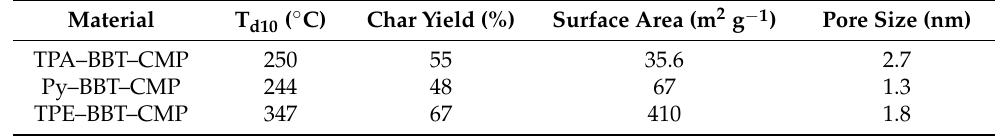
Table 1. A summary of the TGA and porosity properties of BBT–CMPs materials in this study. Material